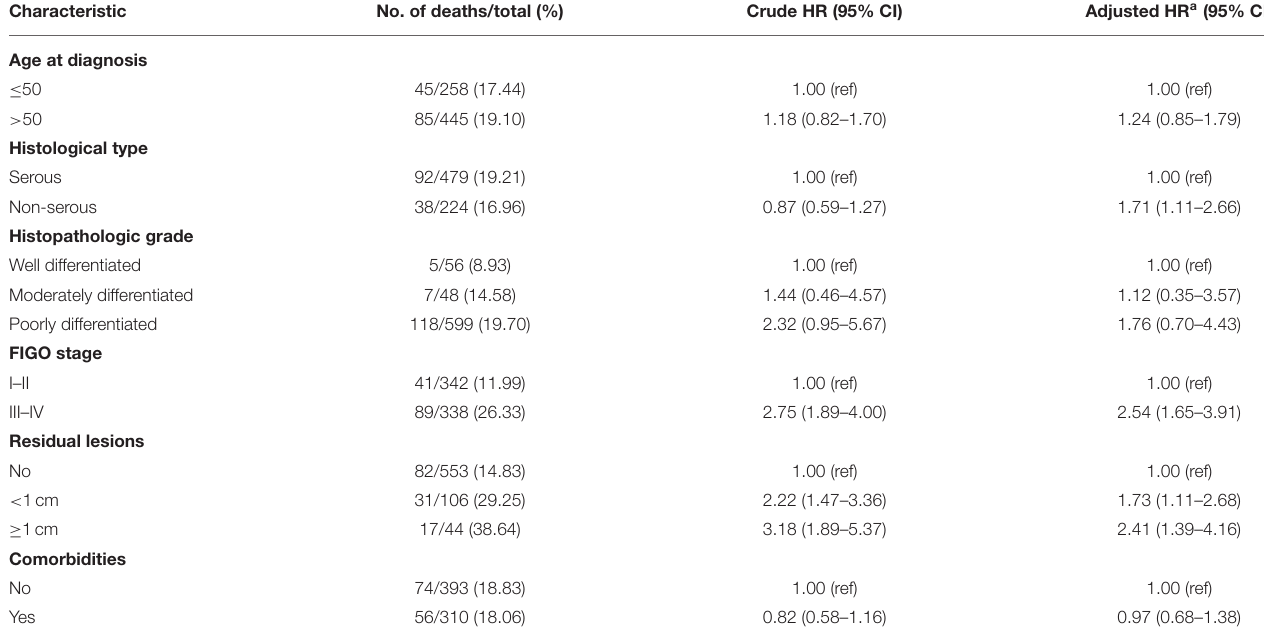
TABLE 2 | Selected clinical characteristics and associations with all-cause mortality among women diagnosed with ovarian cancer ( N = 703).